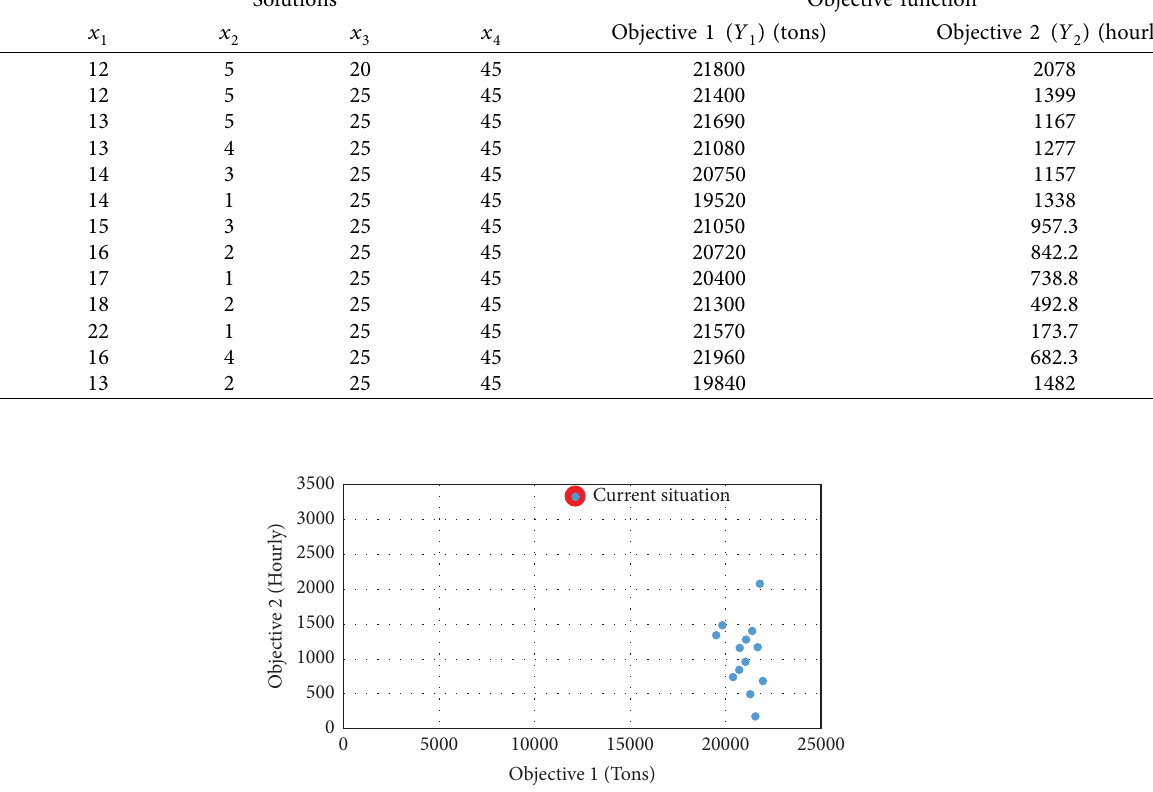
Figure 5: Space of the generated pareto points. Table 11: Optimum and existing situation.